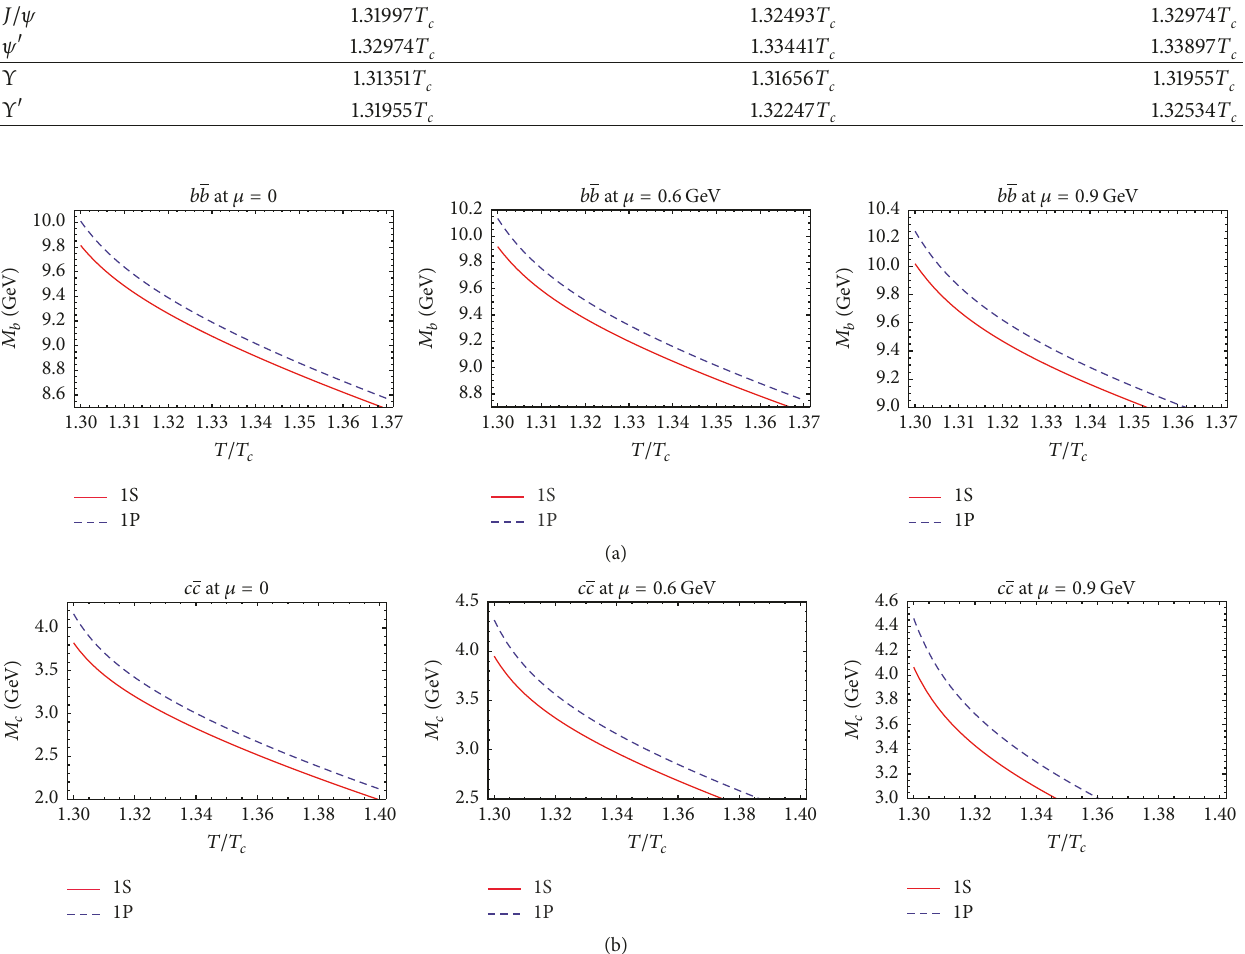
) using m = 1.6 GeV and m c c